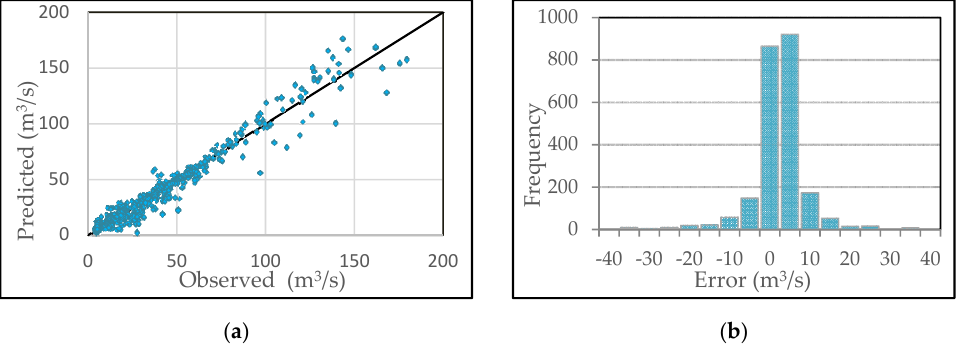
Figure 5. ( a ) Flow forecasts vs measured flows at the Graus station. ( b ) Empirical frequency distribution of the errors (calibration data set).